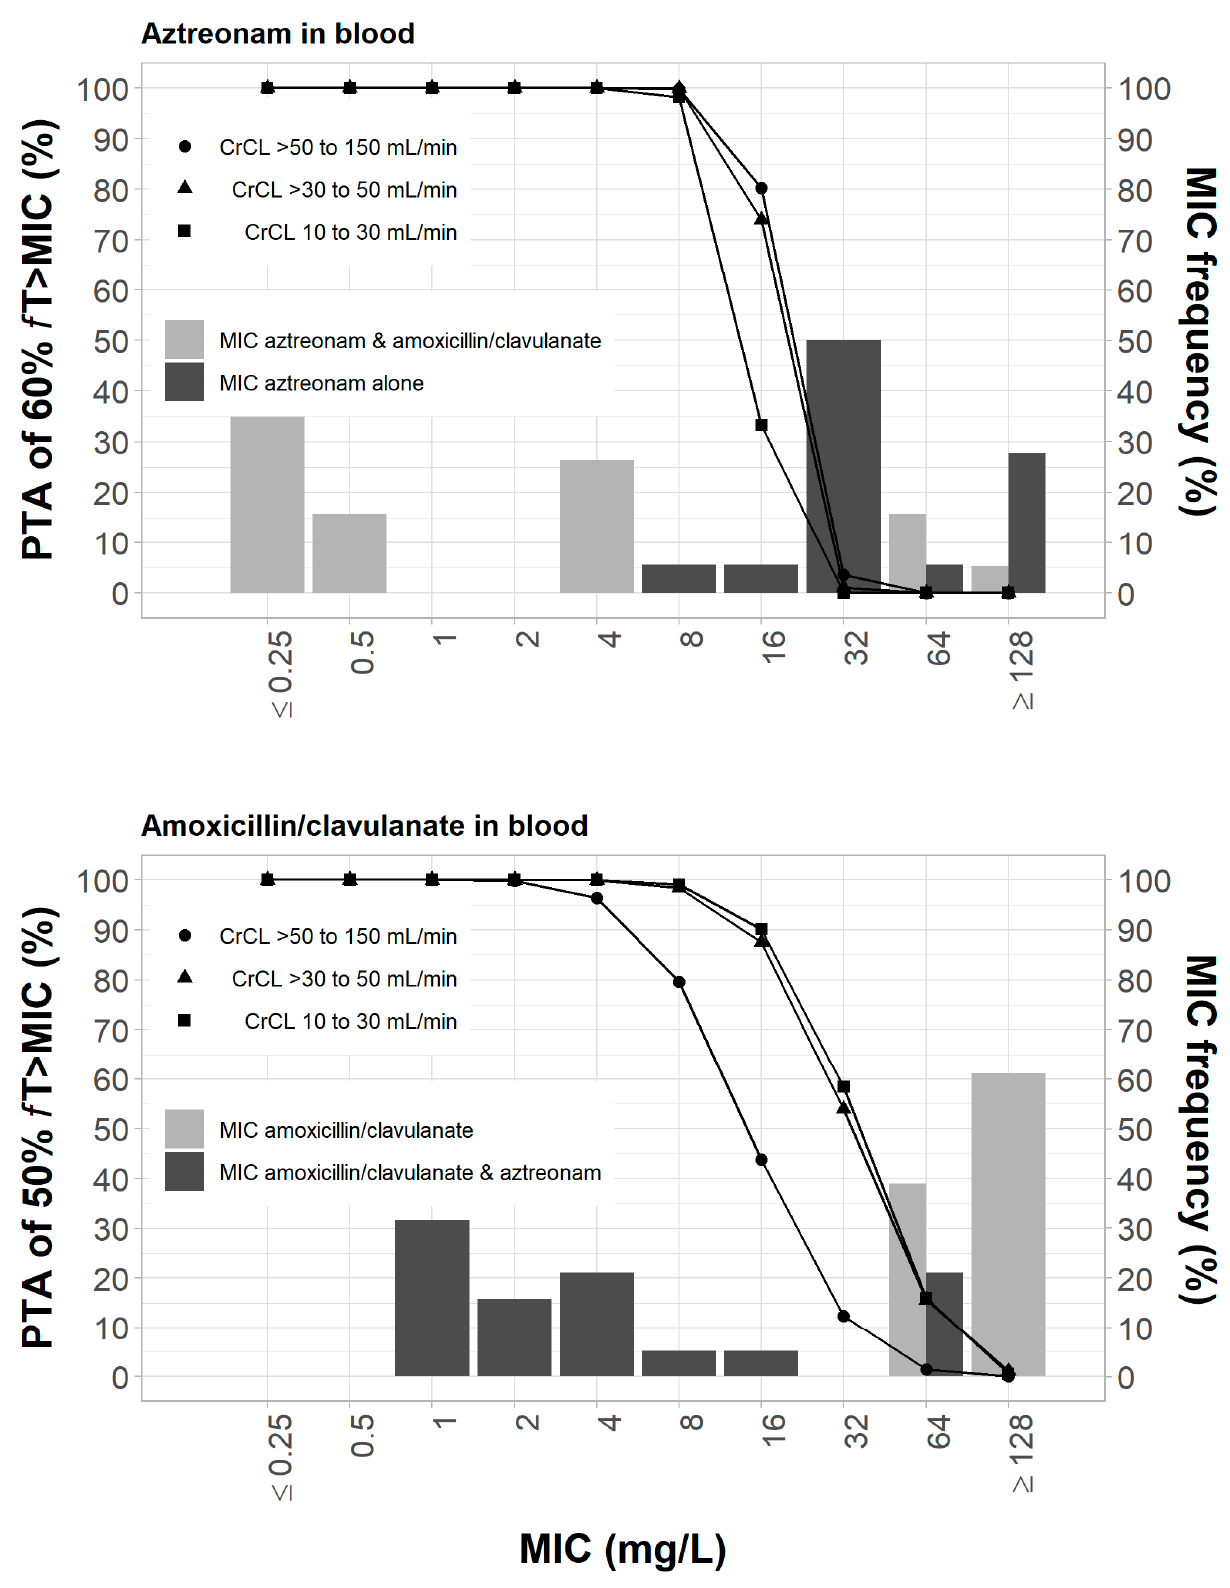
Figure 2. Probability of target attainment of 60% f T >MIC and 50% f T >MIC for aztreonam and amoxicillin/clavulanate dosing regimens by renal function category, respectively, listed in Table 1. Probability of target attainment values were computed based on steady-state drug concentrations in the blood.